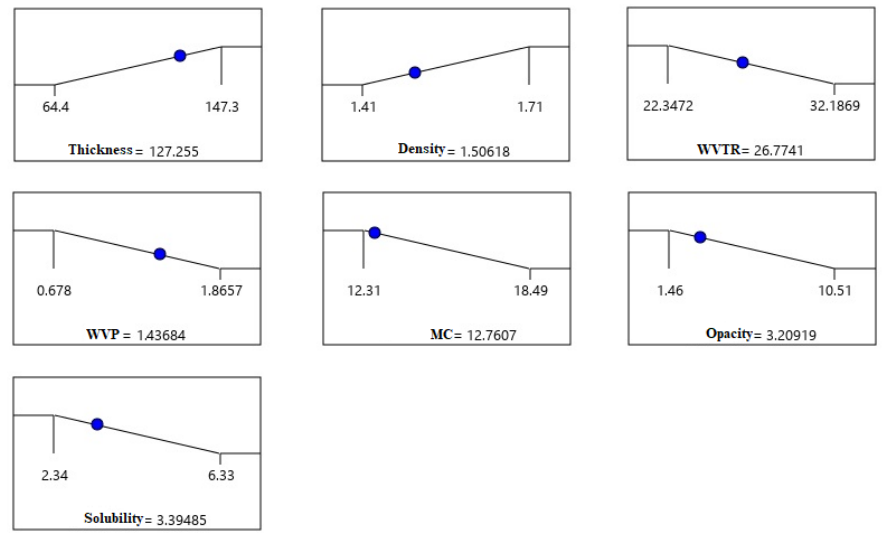
Figure 5. Desirability ramps for optimum points obtained with Design Expert software.